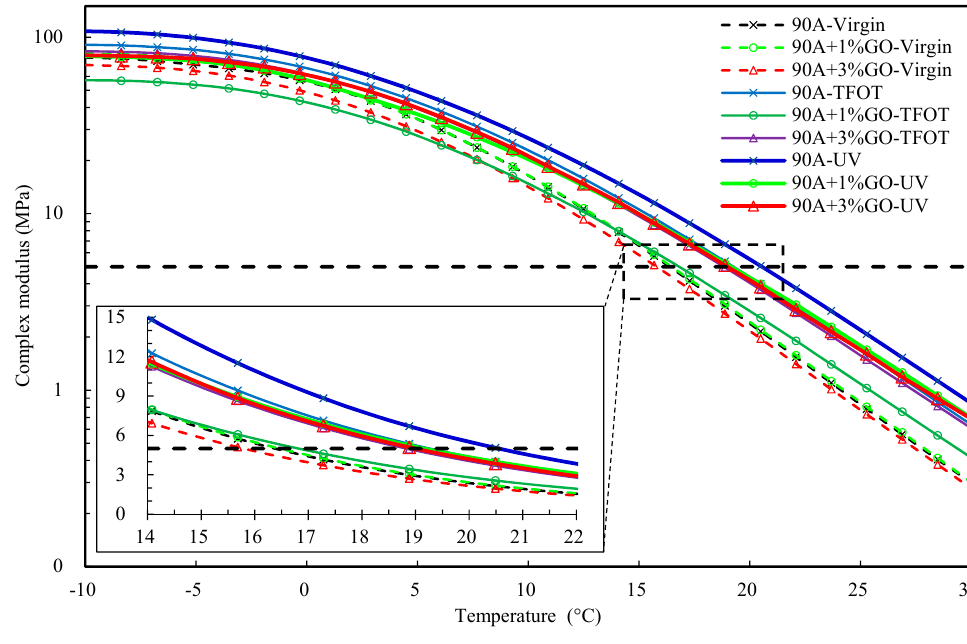
Figure 11. Fatigue cracking factor of 90 A and GO-modified 90 A. Table 2. The FFT of 90 A and GO-modified 90 A.